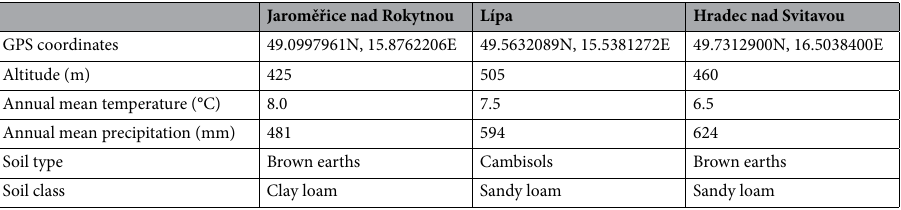
Table 2. Characteristics of the studied